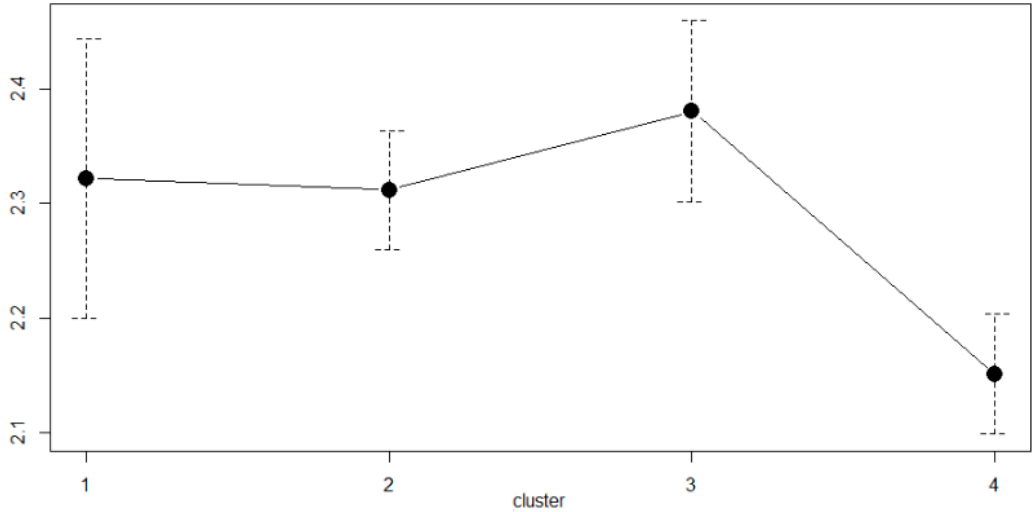
Figure 8. Confidence intervals for the mean number of employees (log transformed) in each cluster.